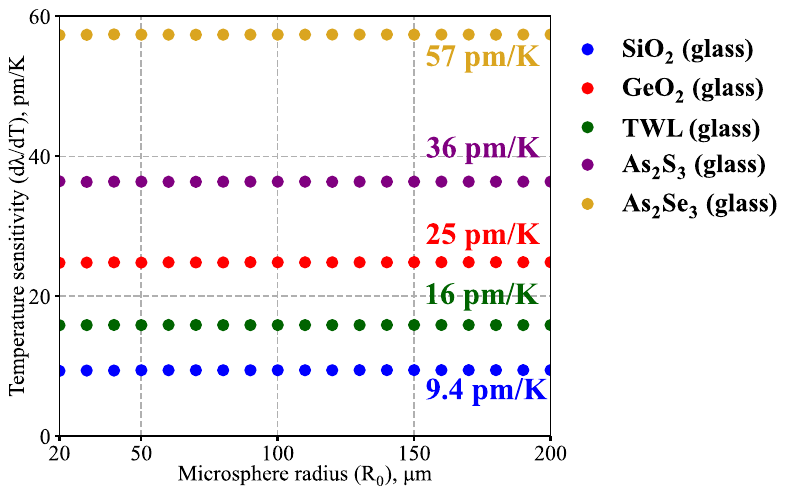
Figure 5. Numerically simulated temperature sensitivity d λ / dT at room temperature ( T 0 = 293 K) as a function of microsphere radius R 0 . Results are shown for fundamental TE modes near λ = 1.55 µ m.